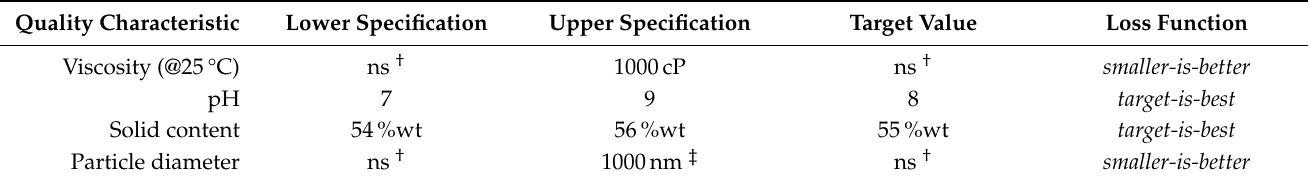
Table 2. Specifications imposed on the quality characteristics of the resin–water emulsions.